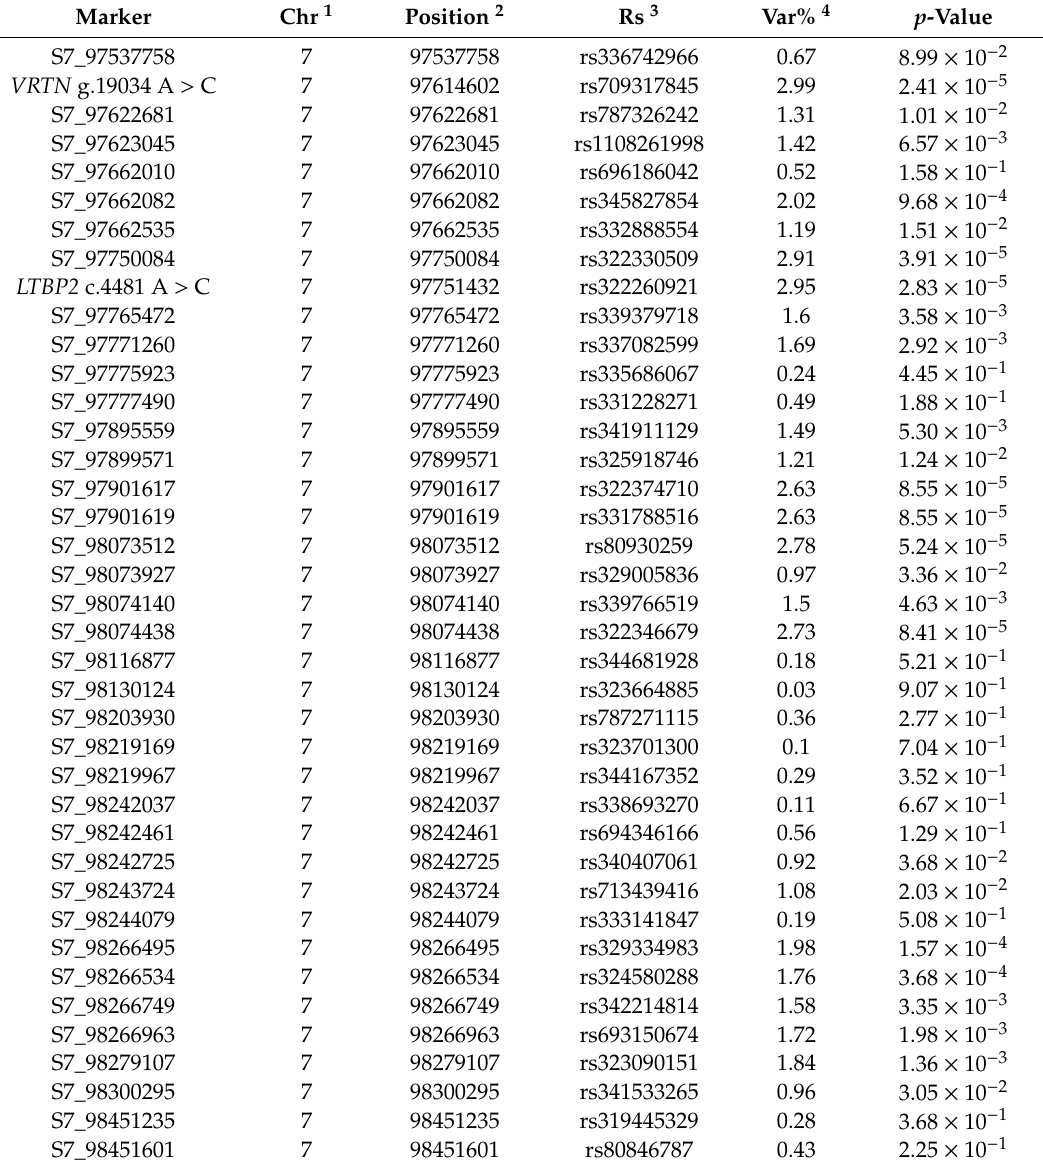
Table 3. Association of 37 missense or splice region variants, VRTN g.19034 A > C, and LTBP2 c.4481 A > C on